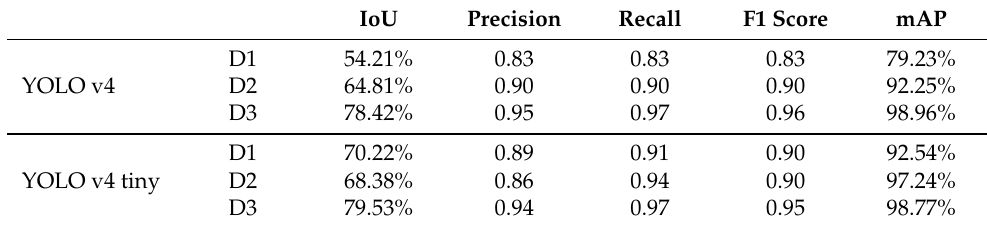
Table 2. Performance evaluation parameters.